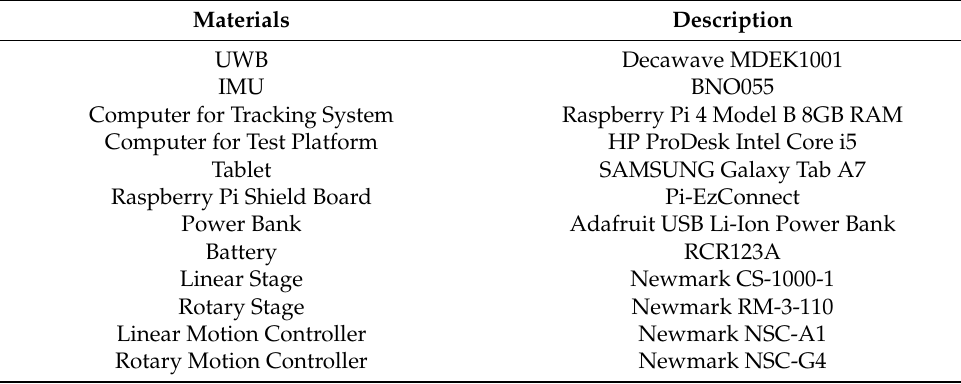
Table 2. Materials used to build the tracking system and test